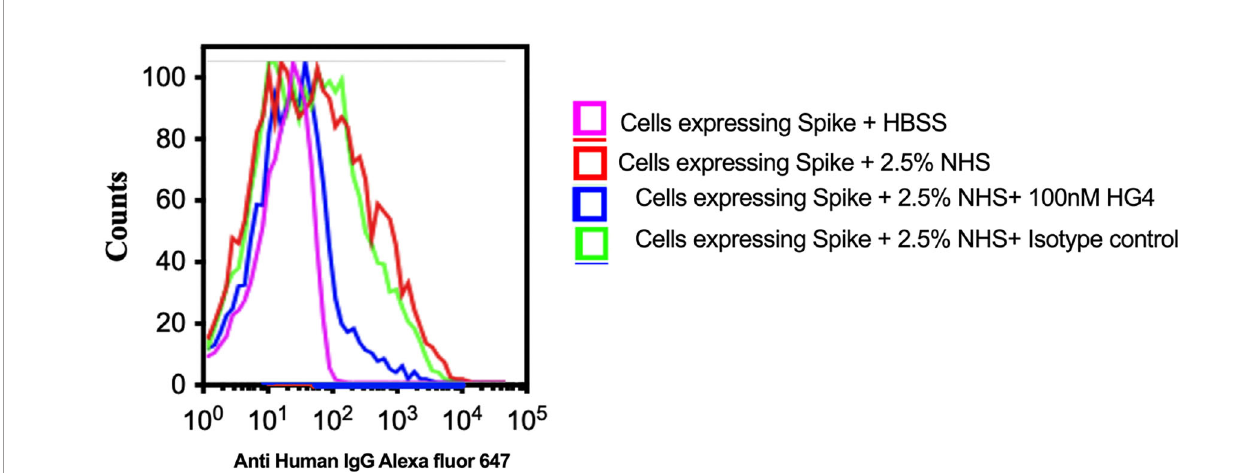
FIGURE 6 | Inhibition of LP impairs complement C3b deposition on SARS-CoV-2 surface proteins. HEK 293T cells expressing SARS-CoV-2 S protein were used. Cells were incubated with 2.5% NHS with 100nM HG4 or an isotype control antibody at 37C for 30 min. Cells were washed and C3b deposition was detected using rabbit anti human C3b followed by goat anti rabbit FITC labelled antibodies. A signi fi cant C3b deposition was detected on HEK 293T cells expressing S protein. Inhibition of MASP-2 using HG4 signi fi cantly impairs complement C3b deposition on the surface of HEK 293T cells expressing S protein.